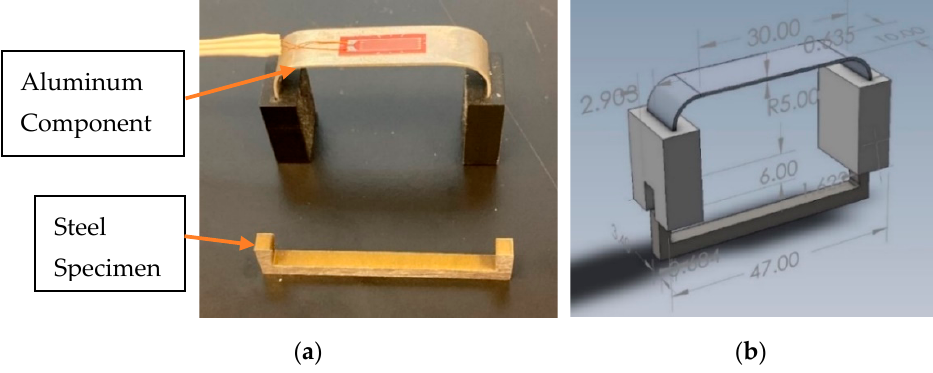
Figure 3. ( a ) Actual corrosion sensor; ( b ) corrosion sensor CAD model.